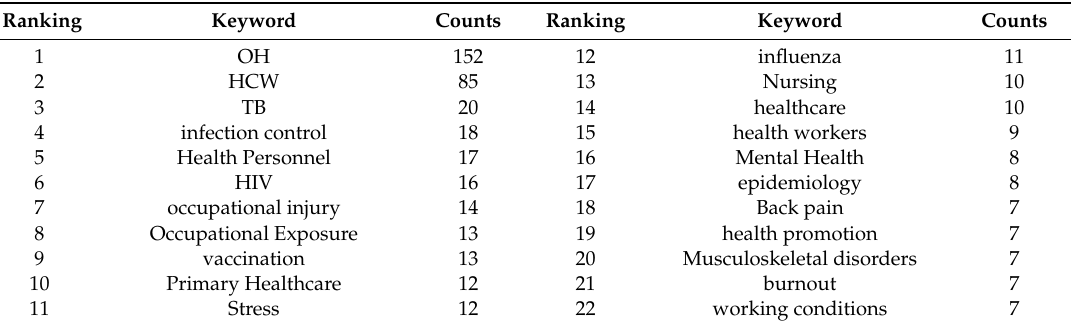
Table 3. Top 22 keywords ranked by counts.